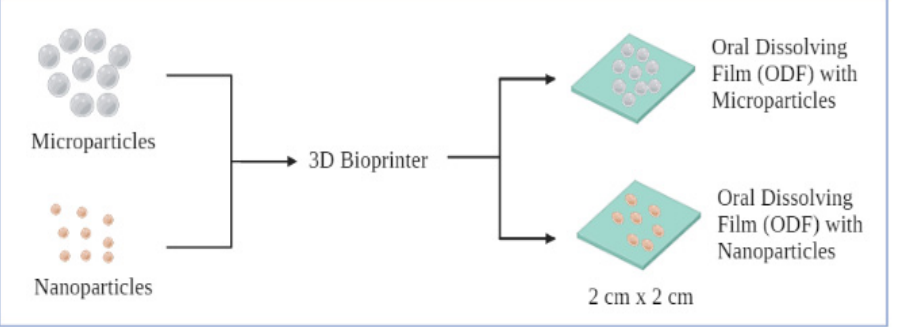
Figure 4. Formulation of oral dissolving films (ODF) with either microparticles or nanoparticles using 3D bioprinter.